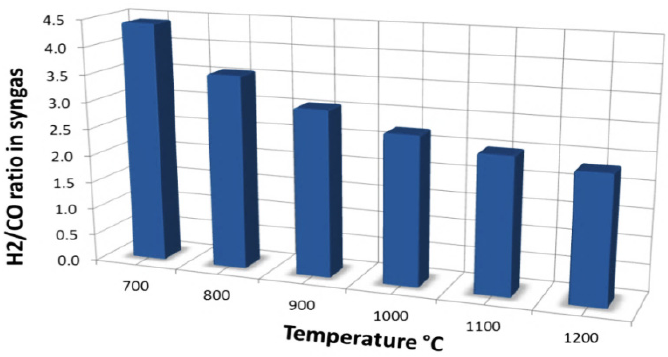
Figure 8. The H 2 /CO ratio in syngas value at 0.1 MPa, ratio w / g 20 and different